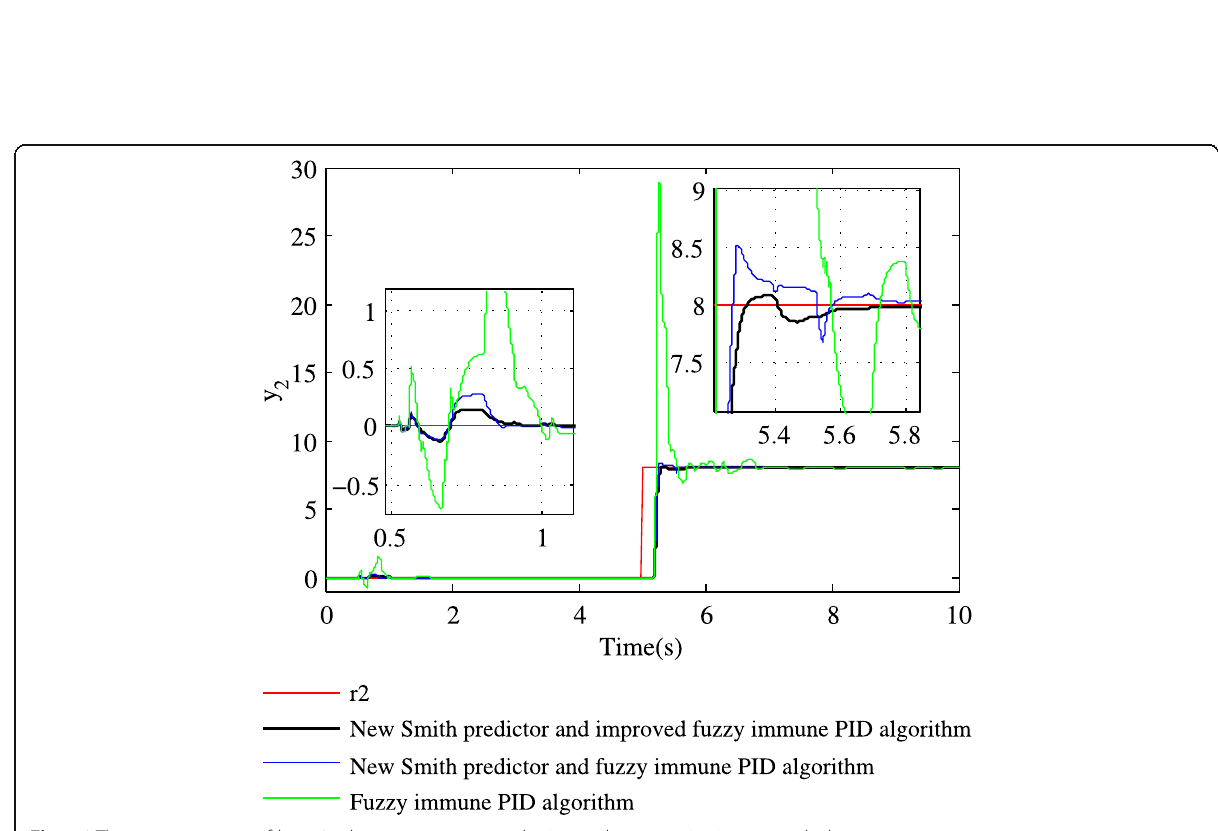
Fig. 16 The step responses of loop 2 when parameter perturbation and communication network